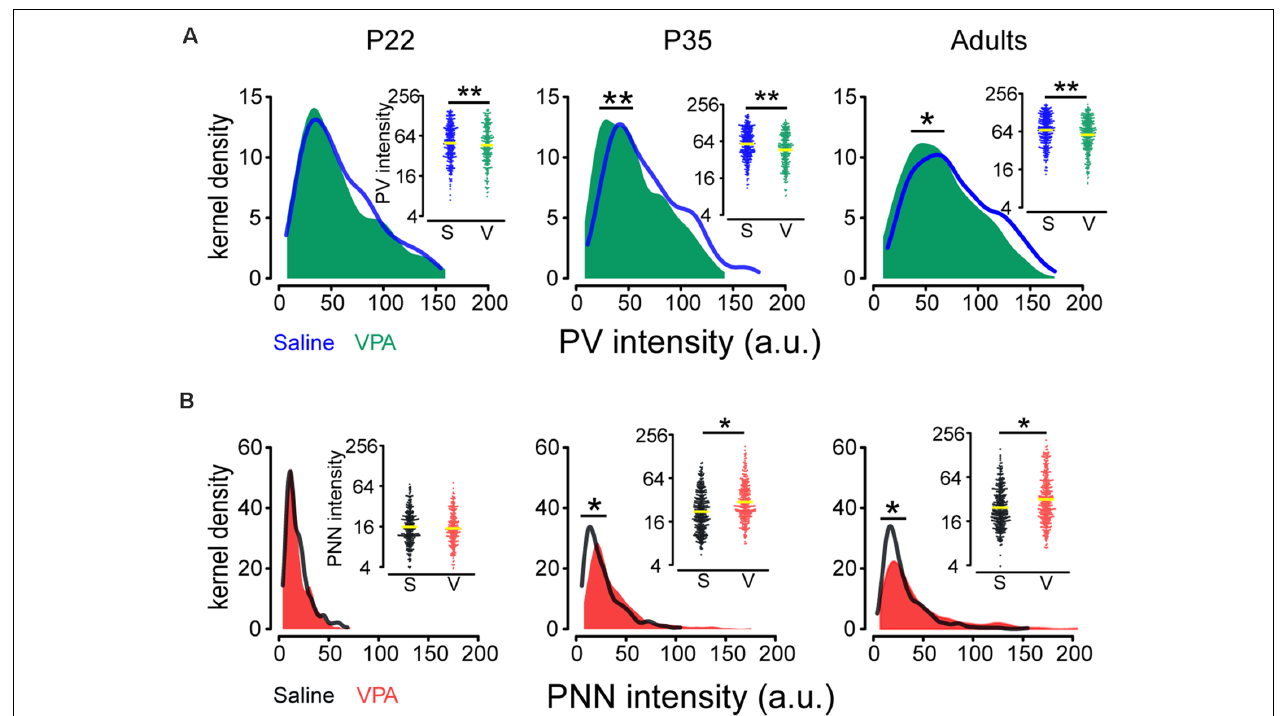
FIGURE 2 | Comparisons of PV and PNN intensities in the PrL-PFC between saline and VPA mice. (A) Kernel density estimation of PV intensity in saline and VPA mice for different ages. Insert: Beeswarm plots of PV intensity. (B) Kernel density estimation of PNN intensity in saline and VPA mice for different ages. Insert: Beeswarm plots of PNN intensity. Yellow lines in inserts indicate geometric means of PV and PNN intensities. Kolmogorov–Smirnov tests were employed to assess disparities in the distribution of PV and PNN intensities between saline and VPA groups using cells as the statistical units. Linear mixed models were applied to compare the means of logarithm transformations of PV intensity [log(PV)] and PNN intensity [log(PNN)] between groups using cells as the statistical units. N = 287, 366, and 351 cells in P22, P35, and adult saline groups, respectively. N = 242, 305, and 348 cells in P22, P35, and adult VPA groups, respectively. * P < 0.05, ** P < 0.01.